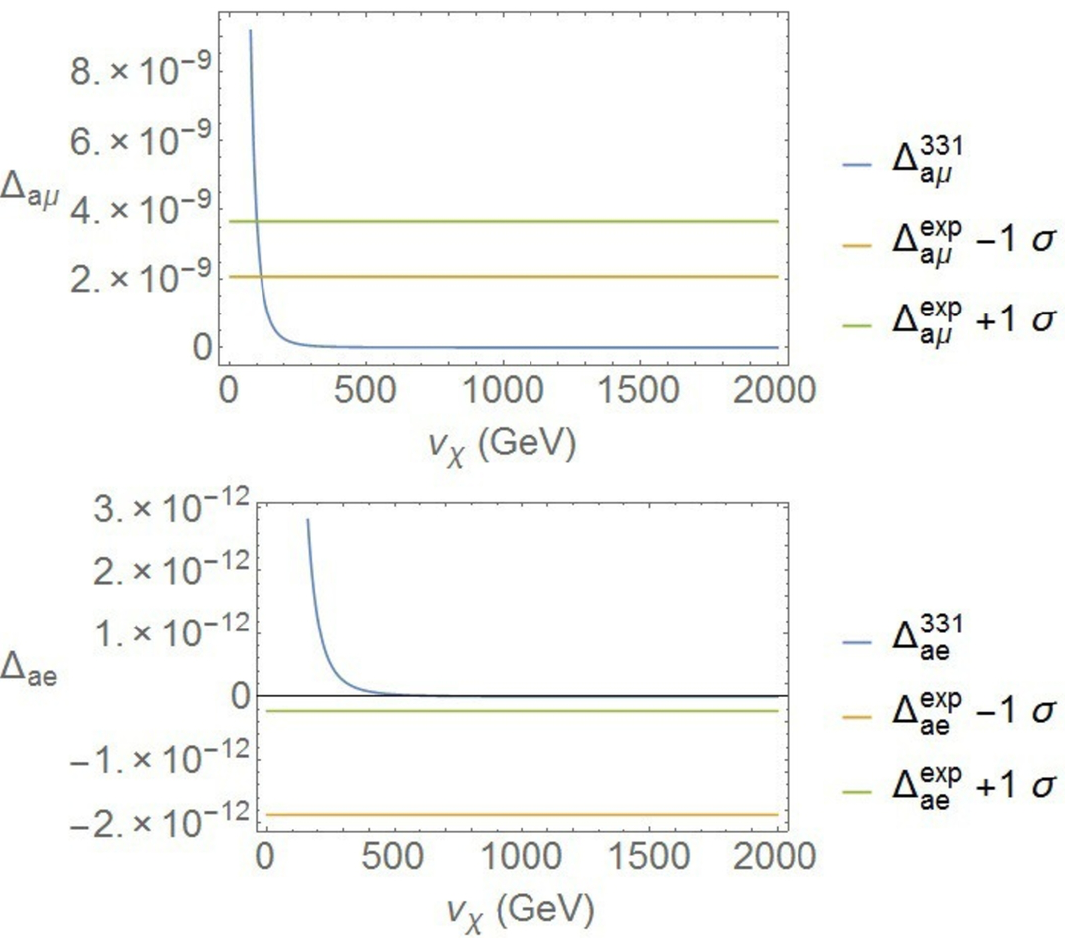
Figure 18 . (cid:1) a e (upper graphic) and (cid:1) a (cid:22) (lower graphic) taking into account only the contribution of the doubly charged scalar Y (cid:0)(cid:0) as function of v (cid:31) , with 0 < v (cid:31) (cid:20) 2 TeV, m also assume that both V L;R are the unit matrix and m Ee = m E(cid:22) = m E(cid:28) = 20 GeV. We see that the muon MDM only has solutions for v (cid:31) (cid:25) 100 GeV, while the electron MDM has no solutions for this